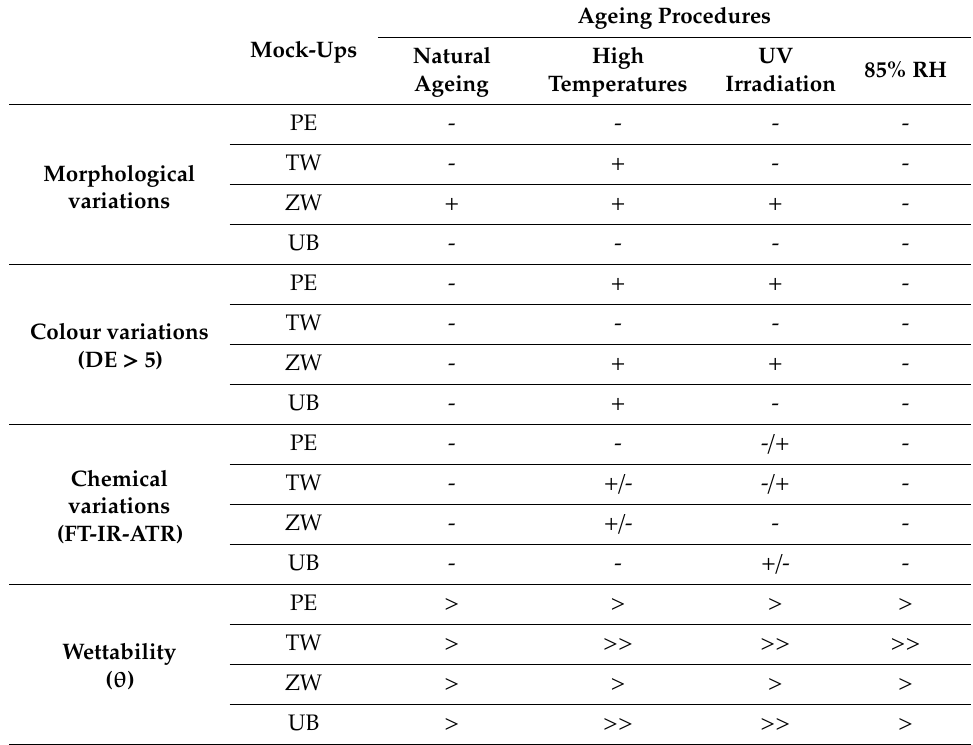
Table 6. Overview of the overall e ff ects of natural and accelerated ageing procedures on mock-ups. Ageing Procedures Mock-Ups